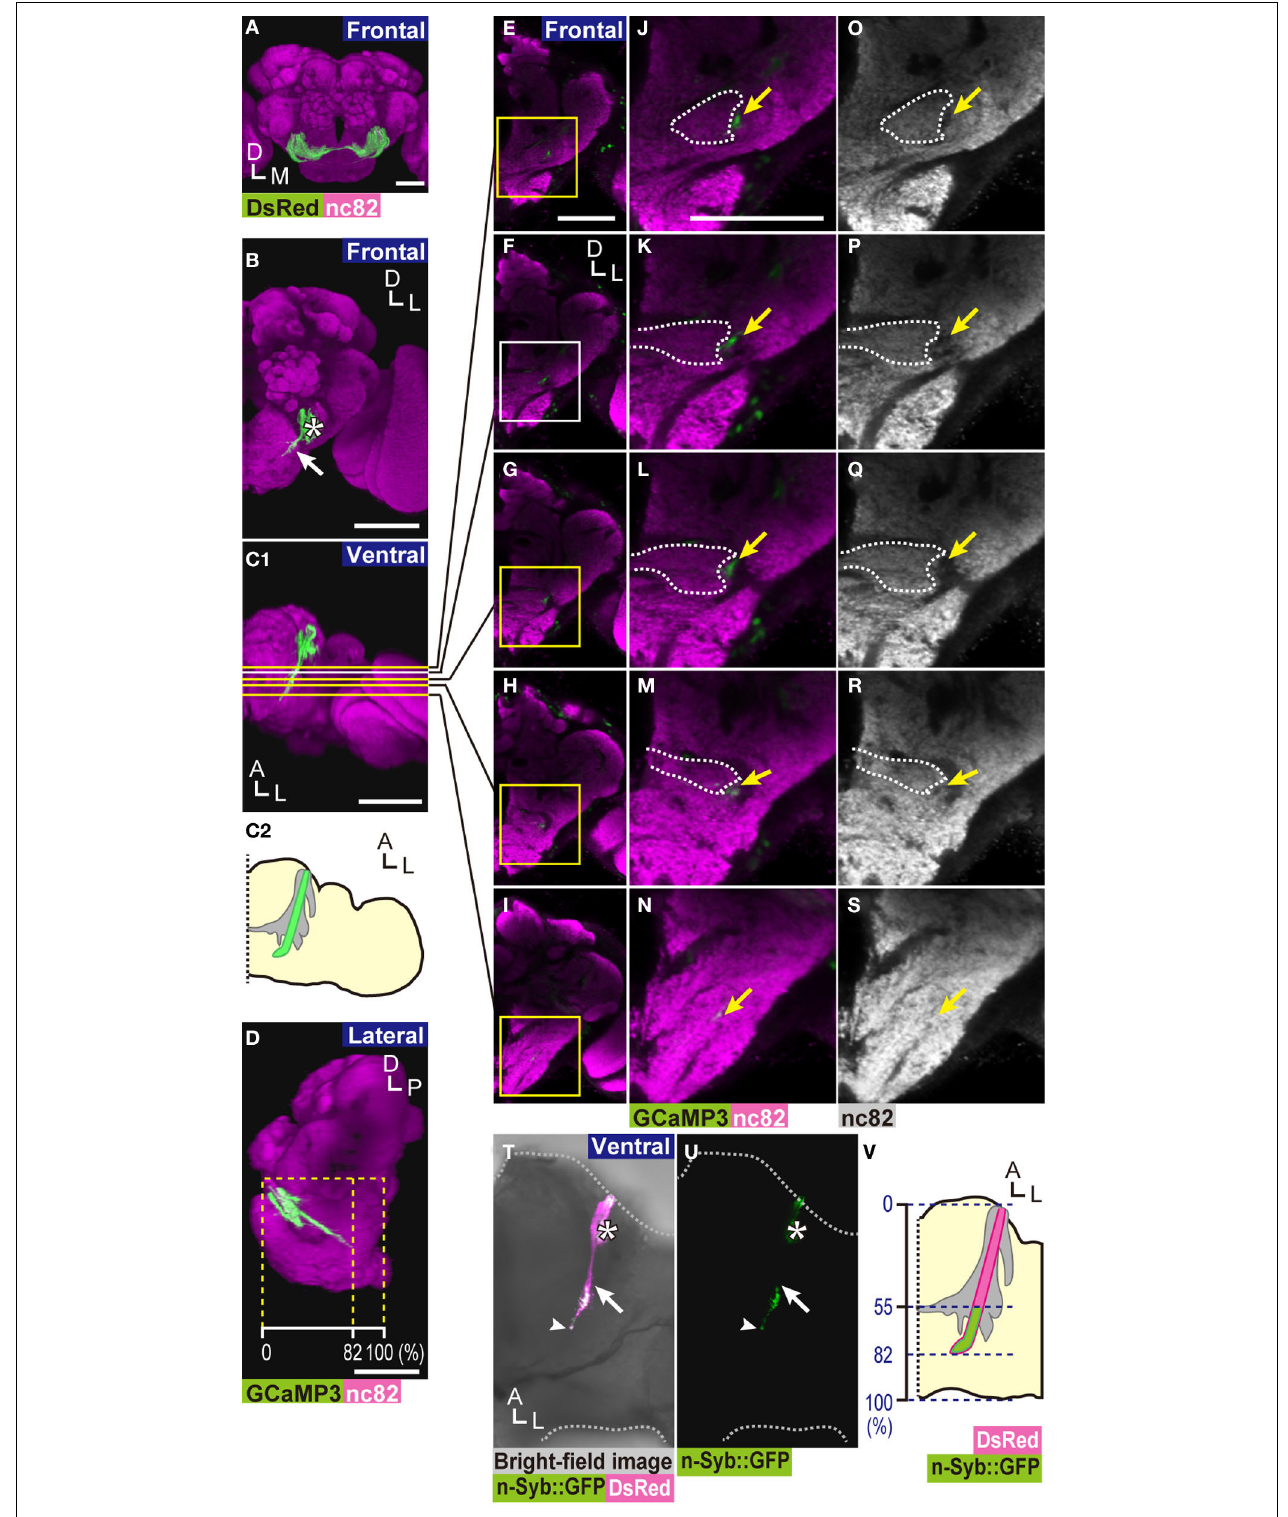
FIGURE 1 | Location of zone D in the brain. (A) 3D-reconstructed frontal image of a fly brain. DsRed marker proteins were expressed in essentially all JO neurons using the F-GAL4 driver (Kim et al., 2003). The AMMC is shown in green. The neuropils of a brain hemisphere were labeled with nc82